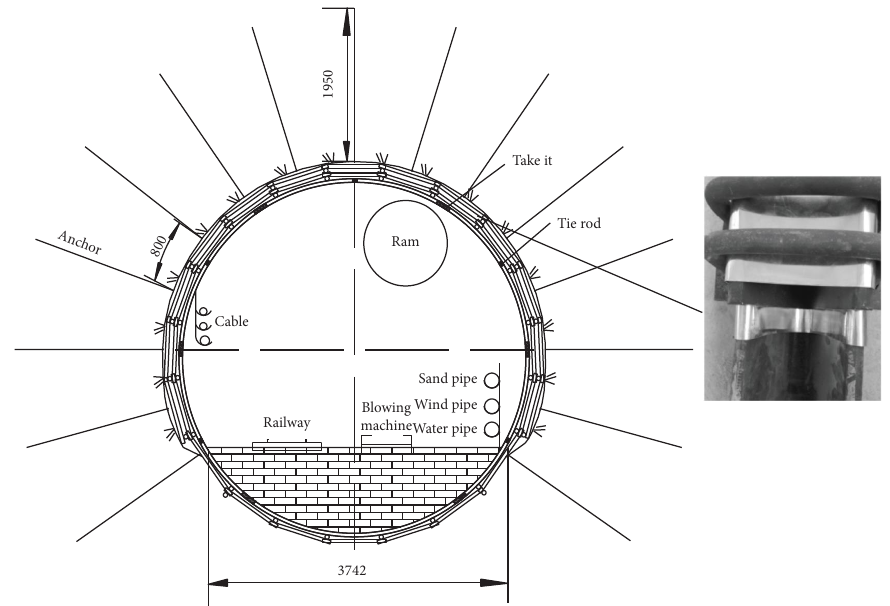
Figure 16: Schematic diagrams of stable structure and constant resistance energy absorption O